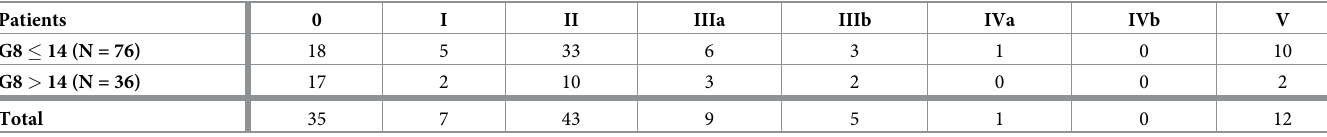
Table 2. Postoperative Clavien-Dindo scores in oncogeriatric patients, according to their G8 score. Patients